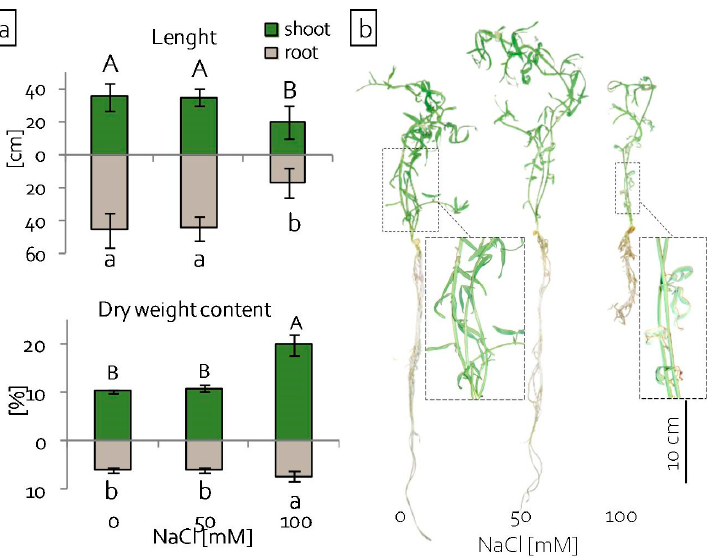
Figure 1. Reaction of grass pea seedlings to salinity stress: ( a ) length ( n = 30) and percentage of dry weight content of shoots and roots ( n = 5); and, ( b ) morphology of shoots and roots; different letters—statistically significant differences within each organ (shoot-uppercase, root-lowercase) at p ≤